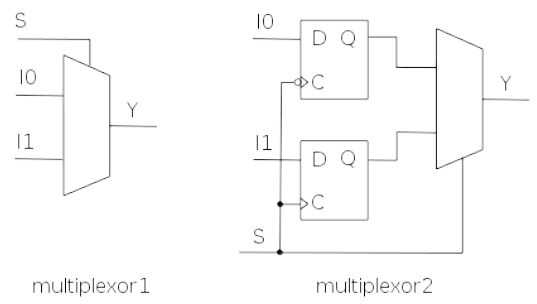
Figure 1. Corresponding schematic diagrams to VHDL code related to